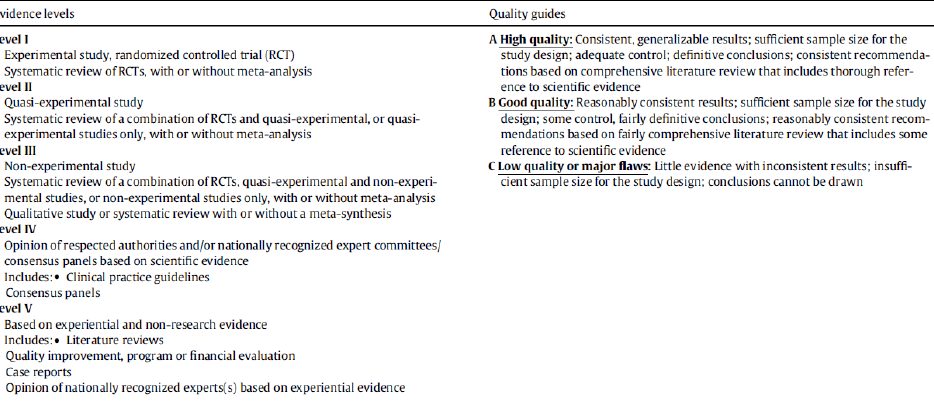
Figure 2. Evaluation of studies according to the John Hopkins Nursing Evidence-Based Practice Model. Levels of evidence and quality.